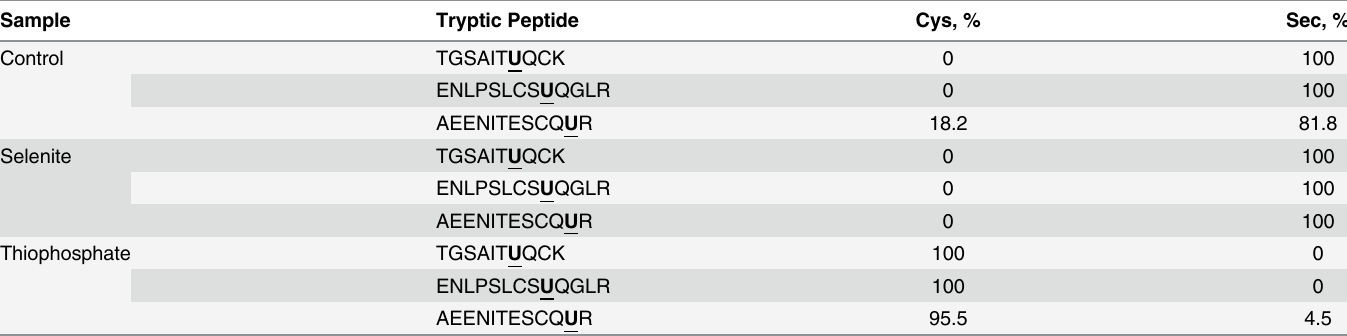
Percent Sec and Cys in SelP peptides was assessed by MS/MS as described in Materials and